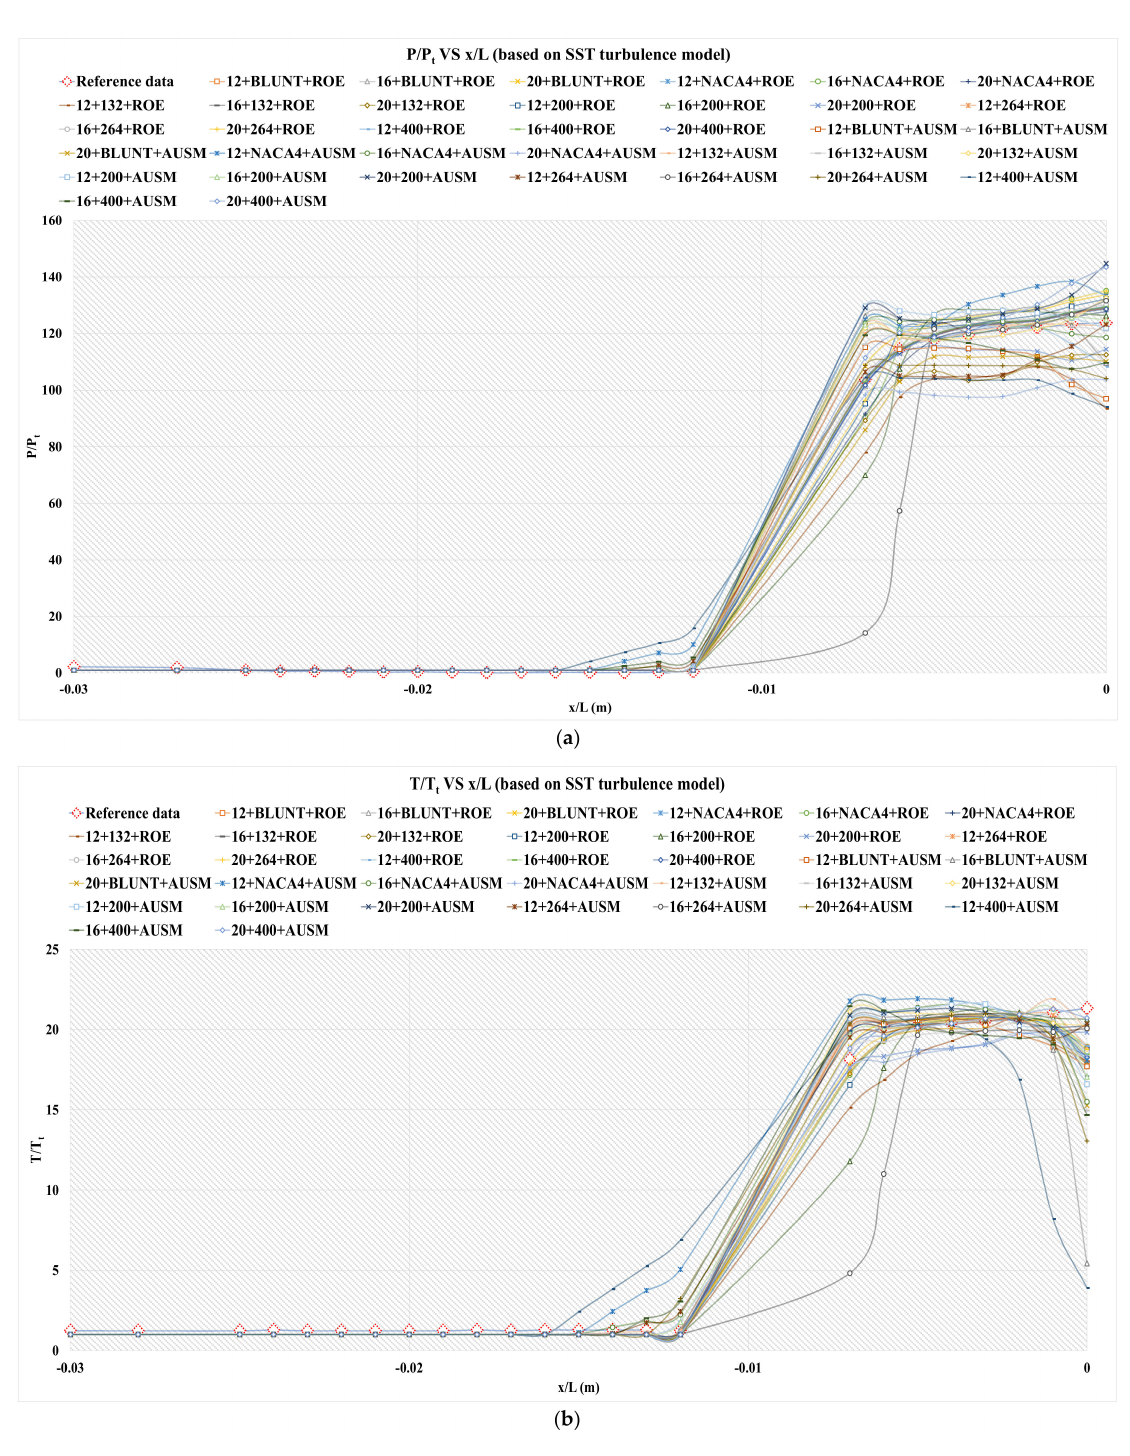
Figure 29. ( a ) Distributions of P/P t of SST turbulence model; ( b ) Distributions of T/T t of SST turbu-lence